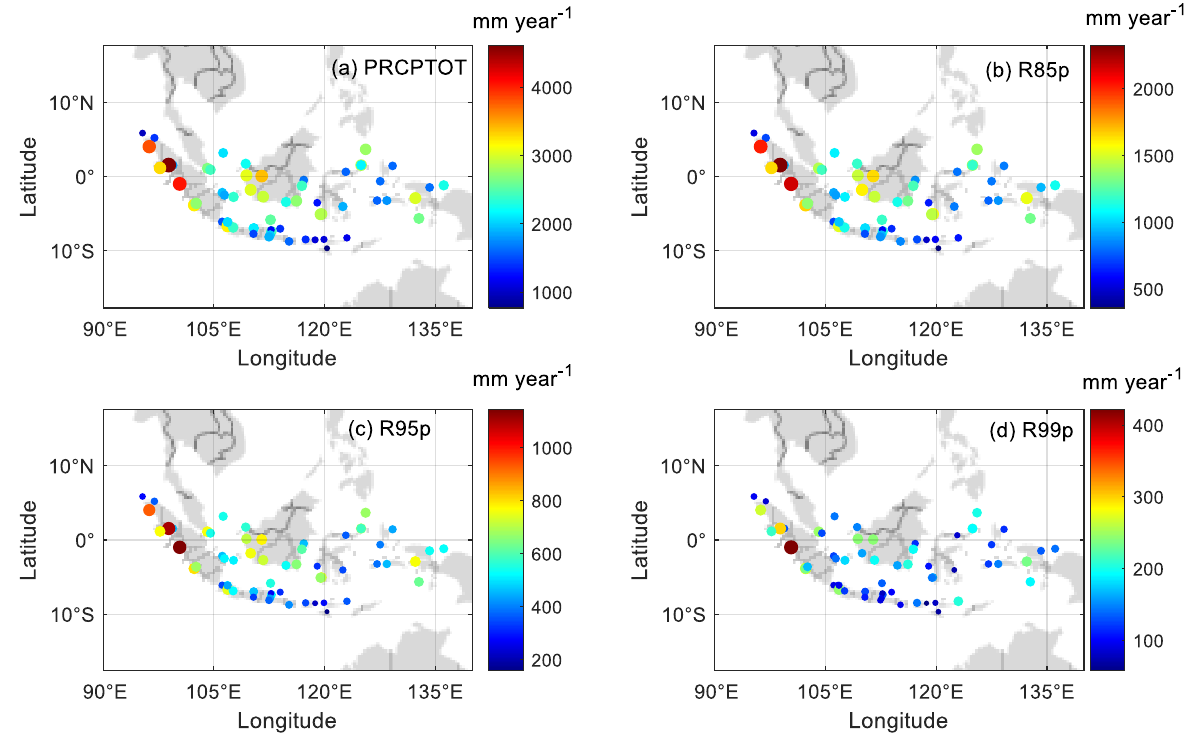
Figure 3. The mean value of precipitation-amount-based indices including PRCPTOT ( a ), R85p ( b ), R95p ( c ), and R99p ( d ), for 63 of BMKG stations in the IMC during 2016 to 2020. R95p ( c ), and R99p ( d ), for 63 of BMKG stations in the IMC during 2016 to